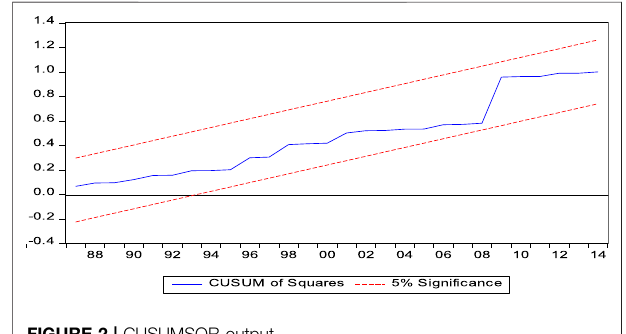
FIGURE 2 | CUSUMSQR